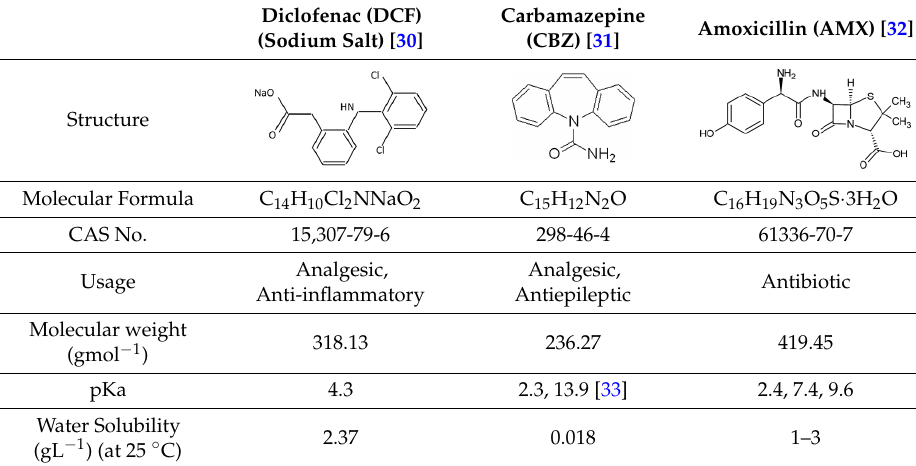
Table 1. Physicochemical properties of diclofenac, carbamazepine and amoxicillin.